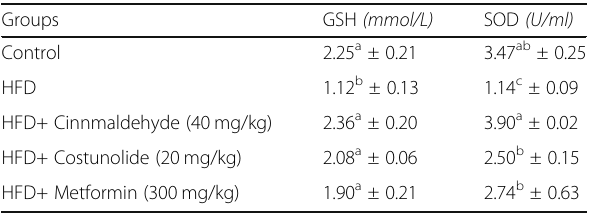
Table 5 Effect of oral administration of cinnamaldehyde and costunolide on plasma antioxidants levels in HFD fed rats for